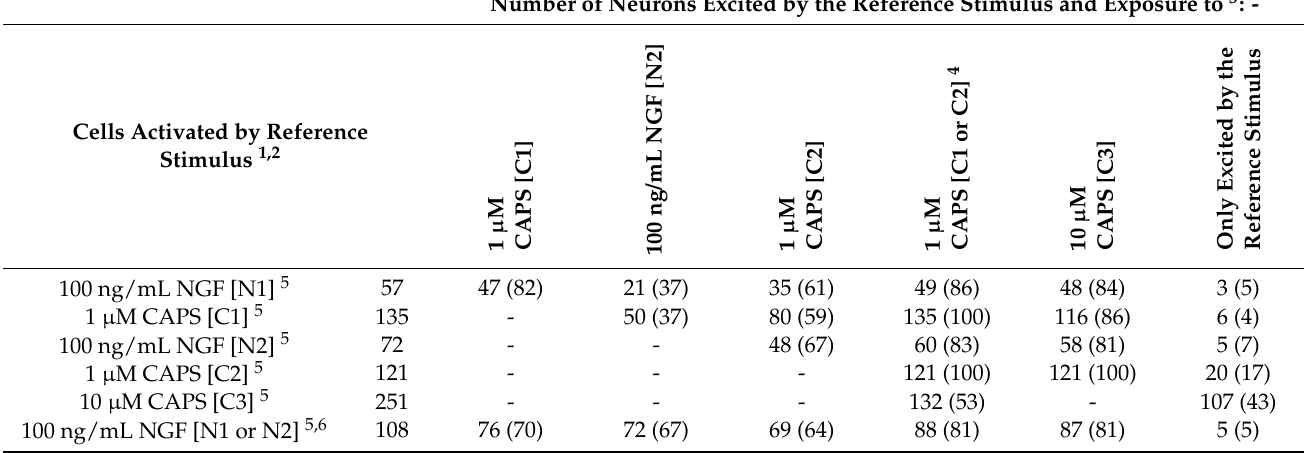
Table 2. Exposure to NGF for 20 min excites CAPS-sensitive neurons if applied to DRG before the vanilloid, and repeated exposure activates even